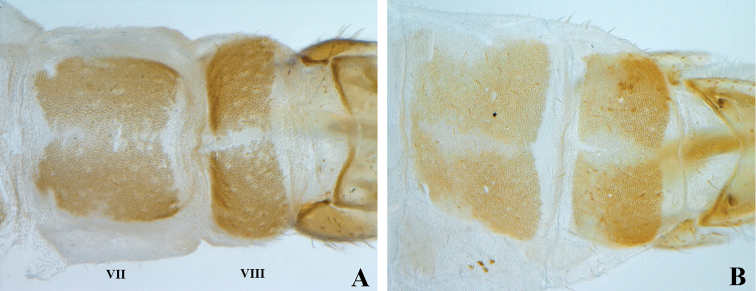
Abdominal terga VII–VIII of Nolima species. ANolimainfensaBNolimavictor.